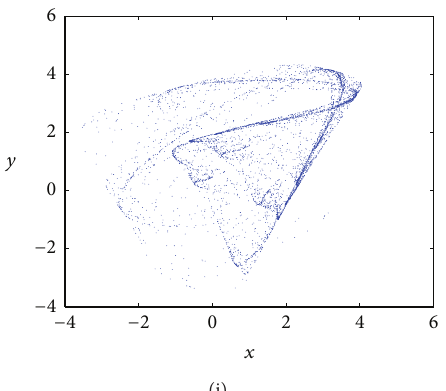
Figure 5: Phase portraits corresponding to Figure 4: (a) 𝑎 = 0.625 , (b) 𝑎 = 0.8 , (c) 𝑎 = 0.85 , (d) 𝑎 = 0.862 , (e) 𝑎 = 0.877 , (f) 𝑎 = 0.892 , (g) 𝑎 = 0.895 , (h) 𝑎 = 0.987 , and (i) 𝑎 = 1.2 .